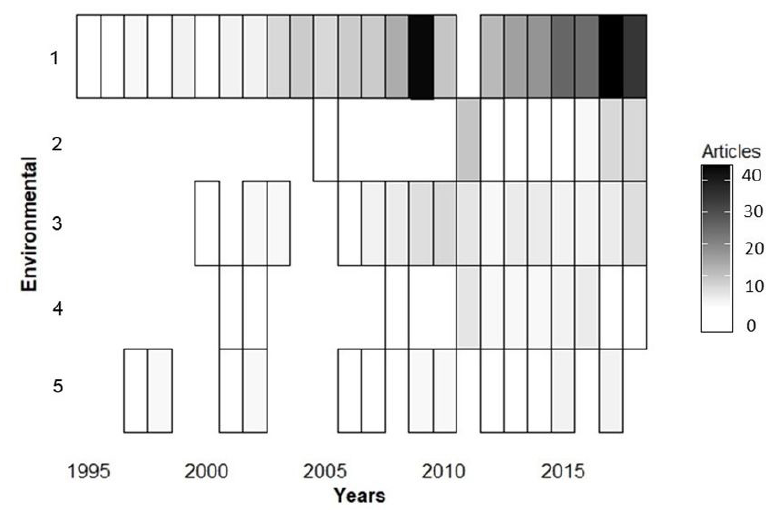
Figure 4. Number of articles from different environments within the study area published from 1995 to 2018 found on the Web of Science (ISI) database. 1. Upper Paraná River floodplain, 2. Upper Paraná River floodplain and others, 3. Paraná System, 4. Ivinhema System, 5. Baía